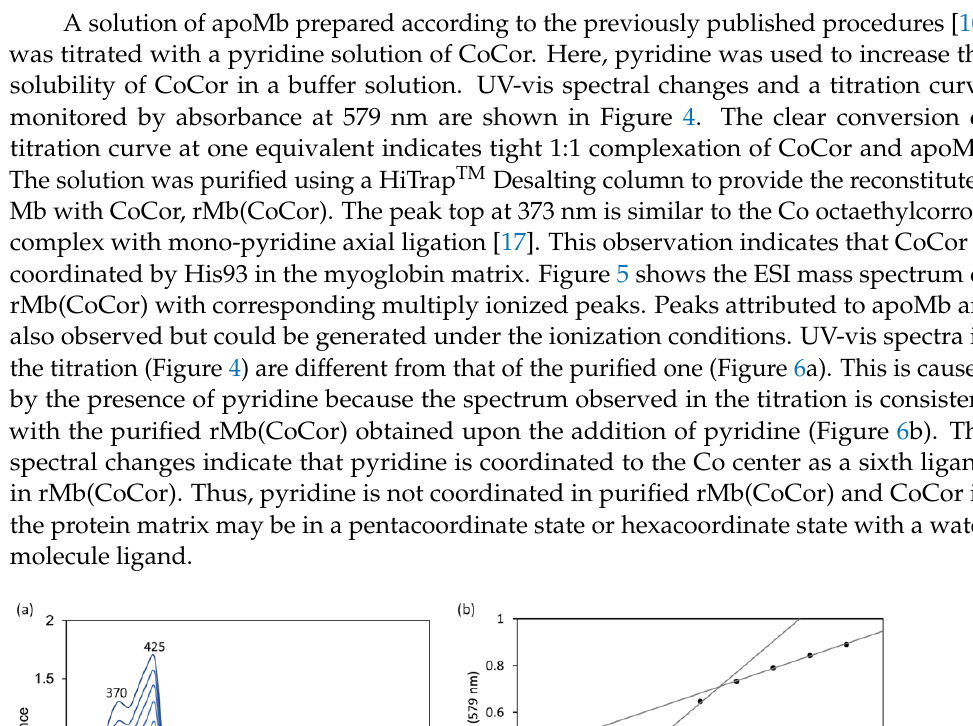
Figure 3. CVs of compound 3 (0.5 mM) ( a ) in DMF and ( b ) in DMF containing 5% pyridine with 100 mM TBAPF 6 under an N 2 atmosphere by various scan rates. Glassy carbon working electrode and Pt counter electrode were used.